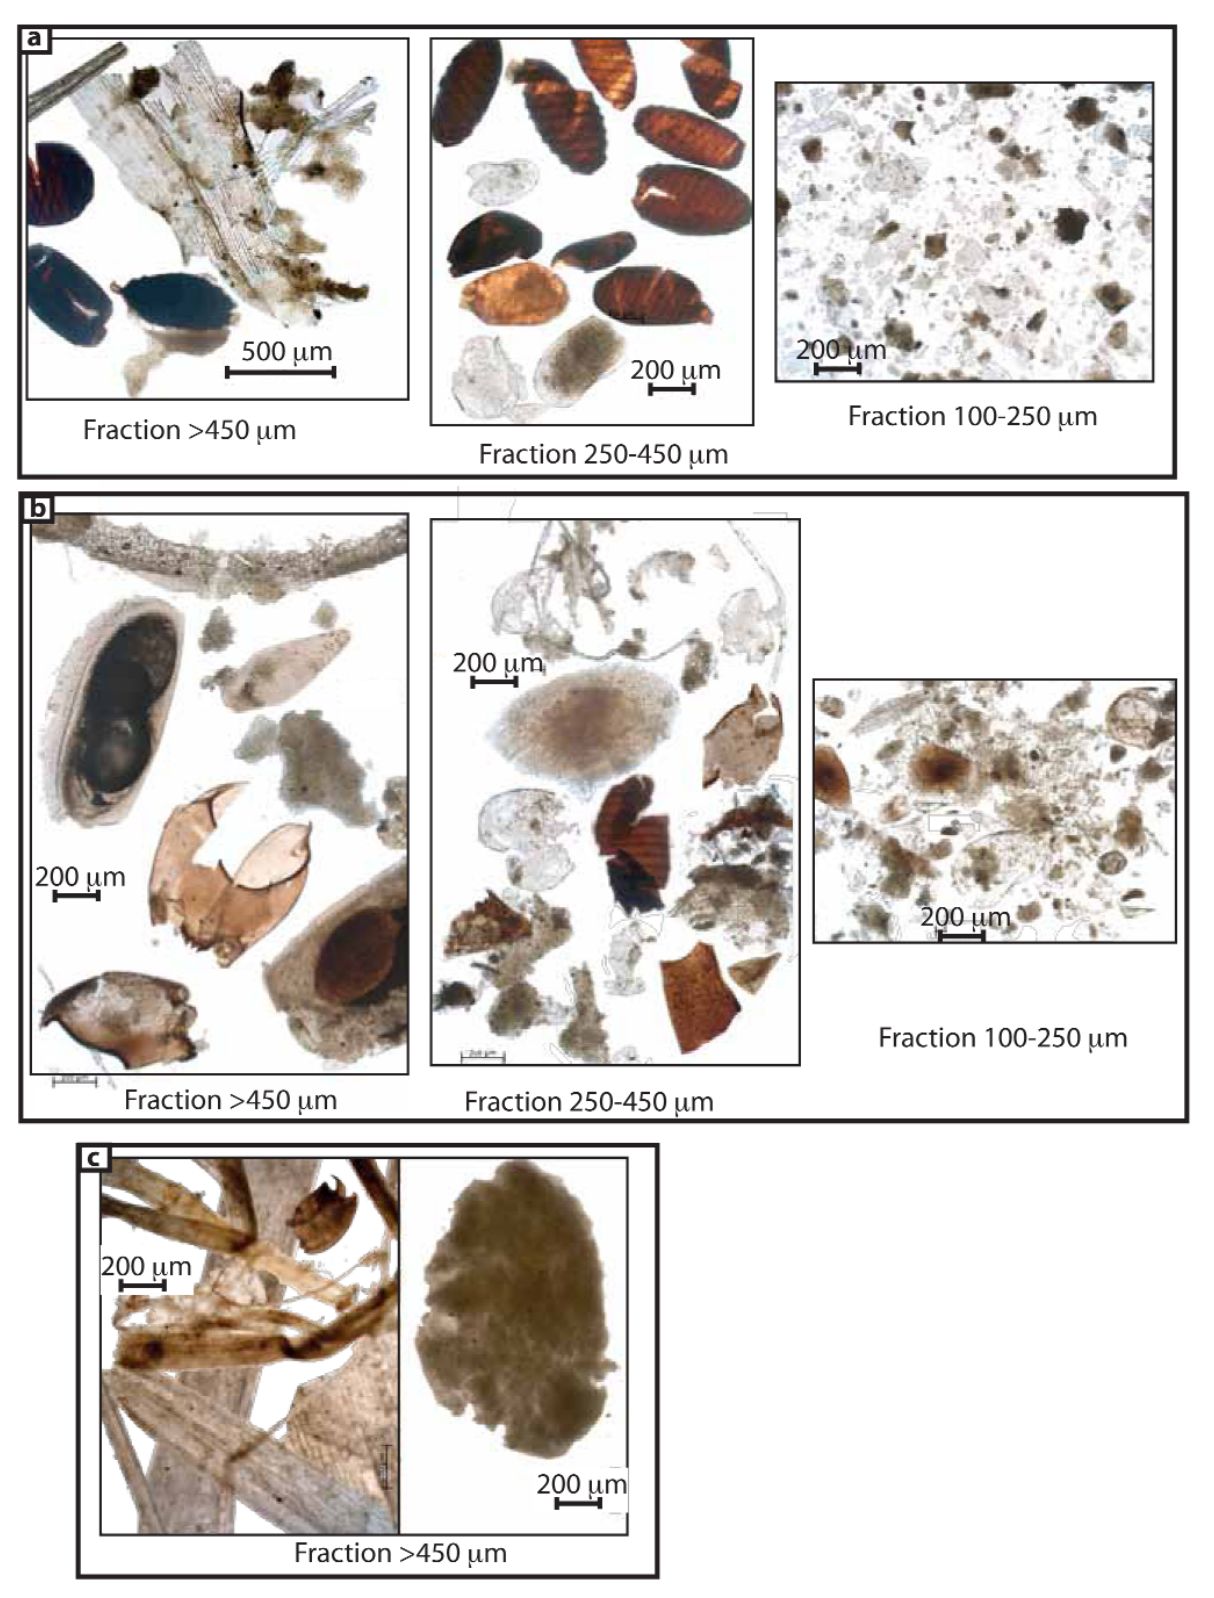
Figure 7. Content of core AT2007: photographs of the different sedimentary fractions after wet sieving; fractions sampled are indicated with a star in Figure 6. a: Sample at the top of unit 1-seq.1 layer. The fraction >450 µm is secondary and contains a few large seeds and phytoclasts; the main 250 µm to 450 µm fraction shows an abundance of ostracods and non-calcified Charophyte seeds (oospores); the 100 µm to 250 µm fraction shows mostly broken ostracods, with some amorphous silty-clay aggregates. b: Sample in a lamina of unit 1-seq.1. The fraction of the >450 µm is more abundant, with a lot of Ephippia of Daphnia , seeds, some chironomids, different types of plant remains; the 250 µm to 450 µm fraction shows a mixture of broken ostracod shells, chironomids, seeds, phytoclasts, amorphous silty-clay aggregates; the 100 µm to 250 µm fraction shows broken ostracoda but in lesser amounts than above, and amorphous silty-clay aggregates. c: Sample in unit 3-seq.2. The sediment is dominated by the >450 µm fraction, composed of various organic fibers, probably including Phragmites and Charophytes remains (right) and silty-clay aggregates